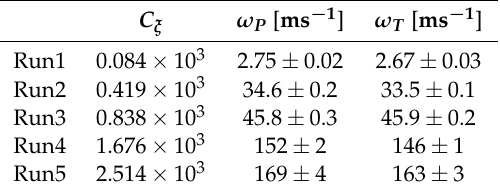
Table 3. Exponential growth rates (in ms − 1 ) for both poloidal ( ω P ) and toroidal ( ω T ) components of the magnetic filed for all runs. The corresponding value of the α -dynamo number C ξ is also reported.